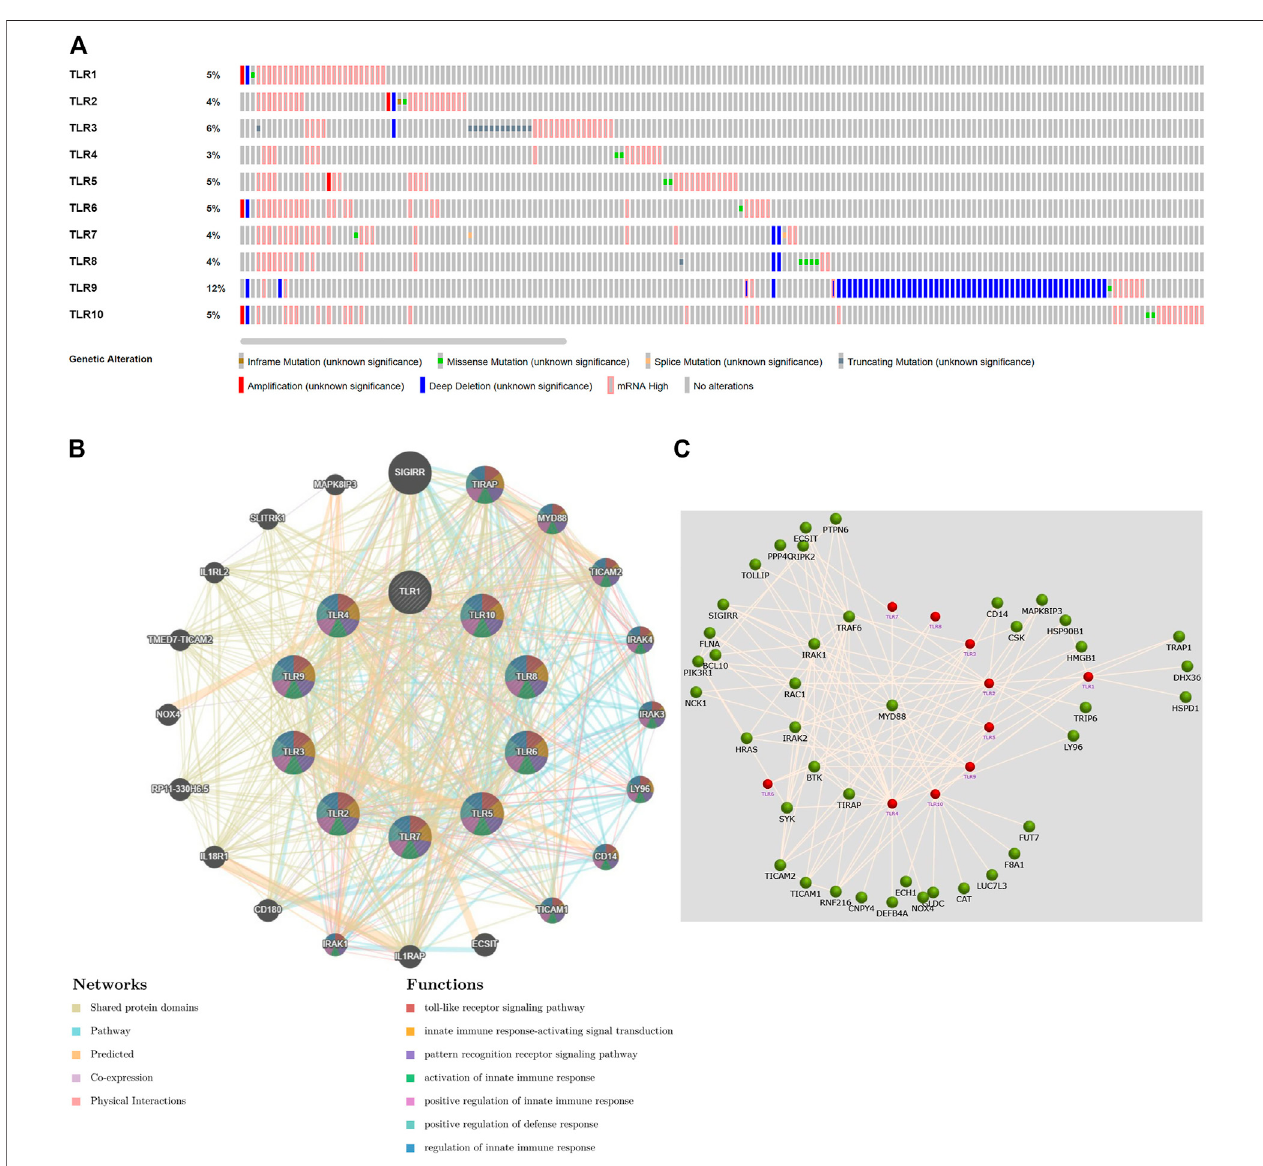
FIGURE7| Genetic alteration, function enrichment ofPPInetwork,genetic interactionanalysesofTLRs inKIRC patients. (A) Genetic alteration ofdifferent TLRs in KIRC. (B) Functional enrichment of TLRs-related PPI network in KIRC. (C) The key gene connecting the TLRs interaction was MYD88.